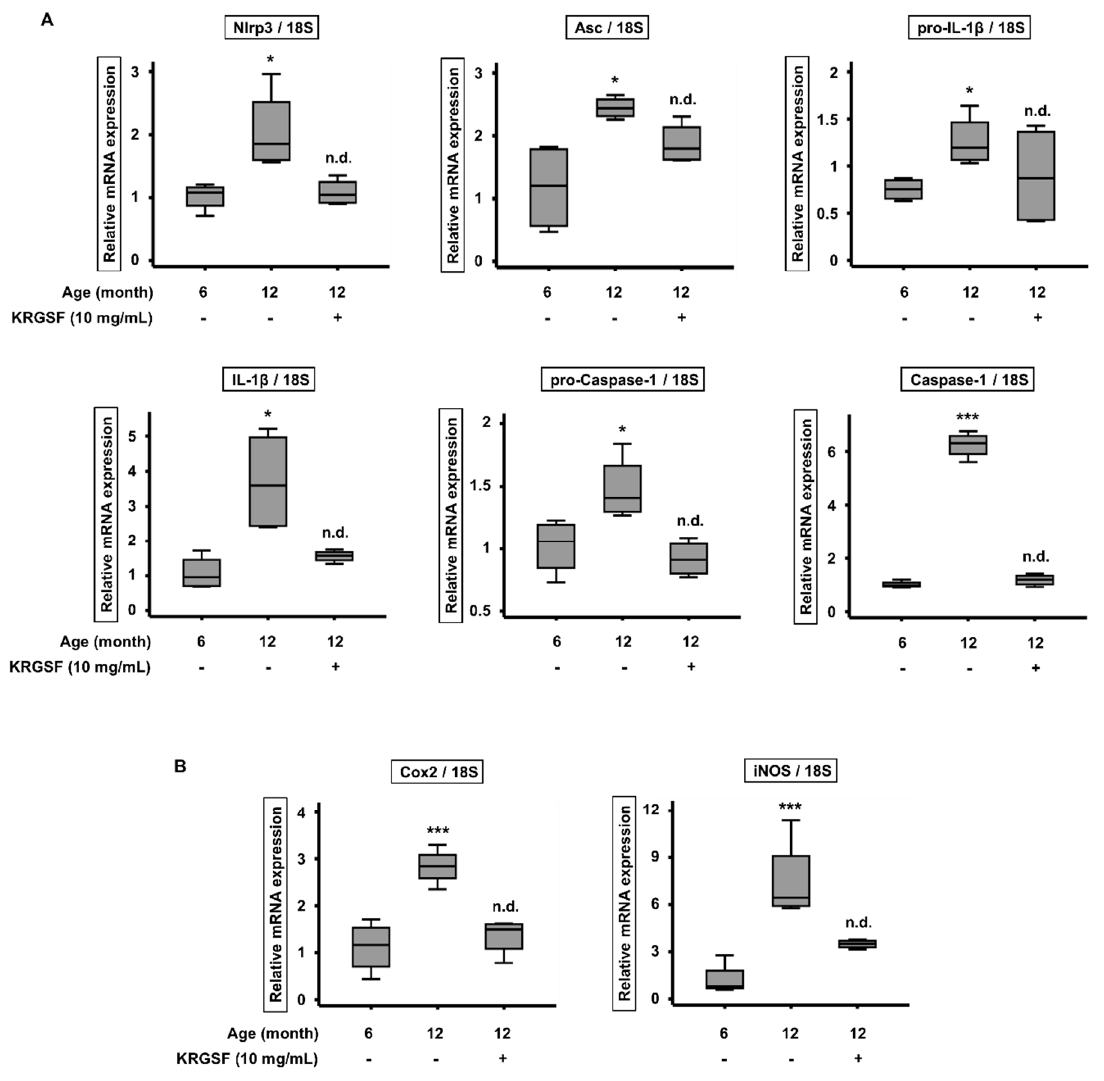
Figure 6. KRGSF ameliorates the aging-related increase in expression of genes encoding NLRP3 inflammasome components. RNA was isolated from ovaries and quantitative RT-PCR analysis was performed. ( A ) The relative mRNA expression of Nlrp3 , Asc , pro-IL-1 β , IL-1 β , pro-caspase-1, and caspase-1 (mean ± SEM; n = 4). ( B ) The relative mRNA expression of Cox2 and iNOS2 (mean ± SEM; n = 4). 18S was used as a reference gene. * p < 0.05, ** p < 0.01, and *** p < 0.005 vs. the 6-month-old untreated group. n.d. (no difference).